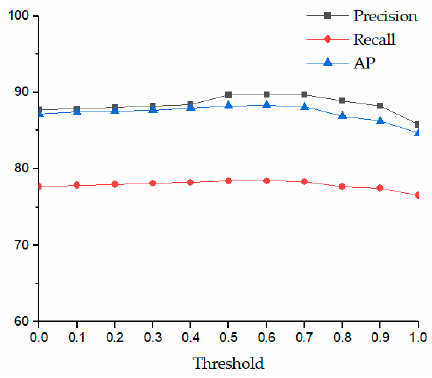
Figure 10. Detection accuracy under different thresholds, P tr